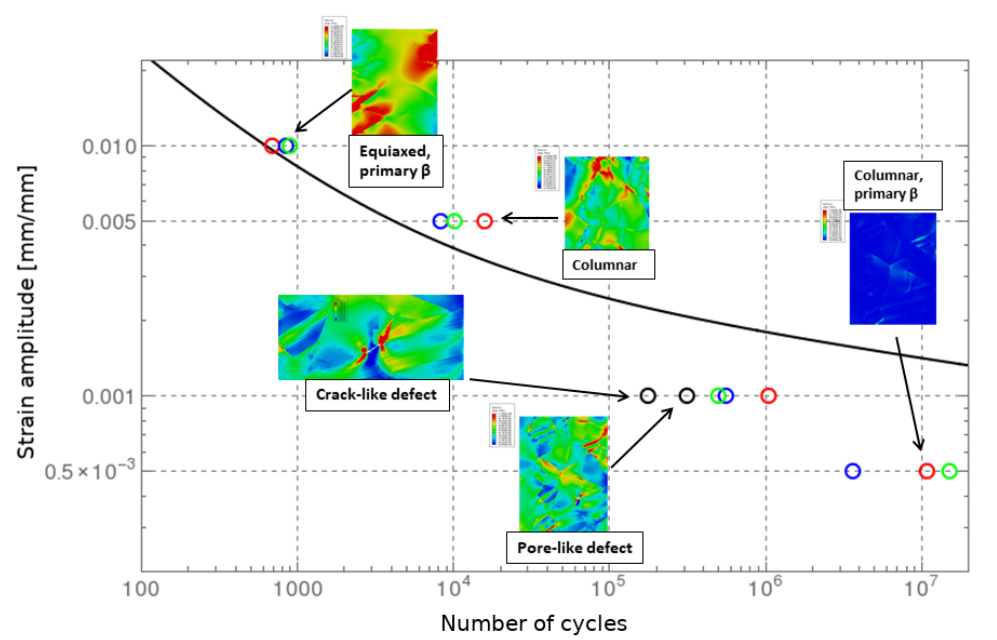
Figure 8. Cycles to fatigue failure vs. strain amplitude of Ti-6-4. according to a micromechanical finite element model. Circles with different colors point to different selective laser melting (SLM) microstructures, as specified in the graph. The black line is an approximate curve based on the simulations. Microstructures denoted with “primary β ” do not have a martensitic